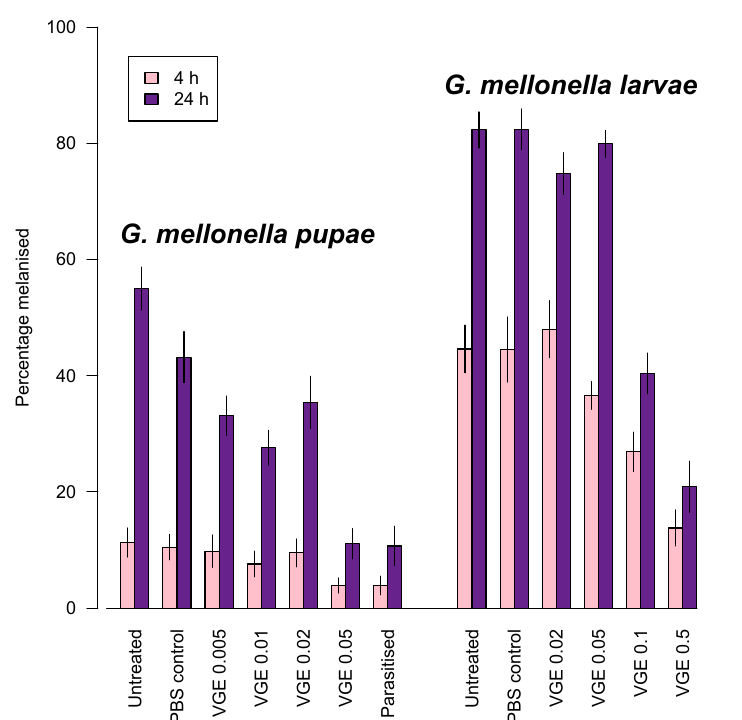
Figure 16. Melanisation of Sephadex DEAE A-25 beads in Galleria mellonella pupae and larvae experimentally envenomated and parasitised by P. turionellae after 4 and 24 h. (Source: data from Tables 4 and 5 [246]).